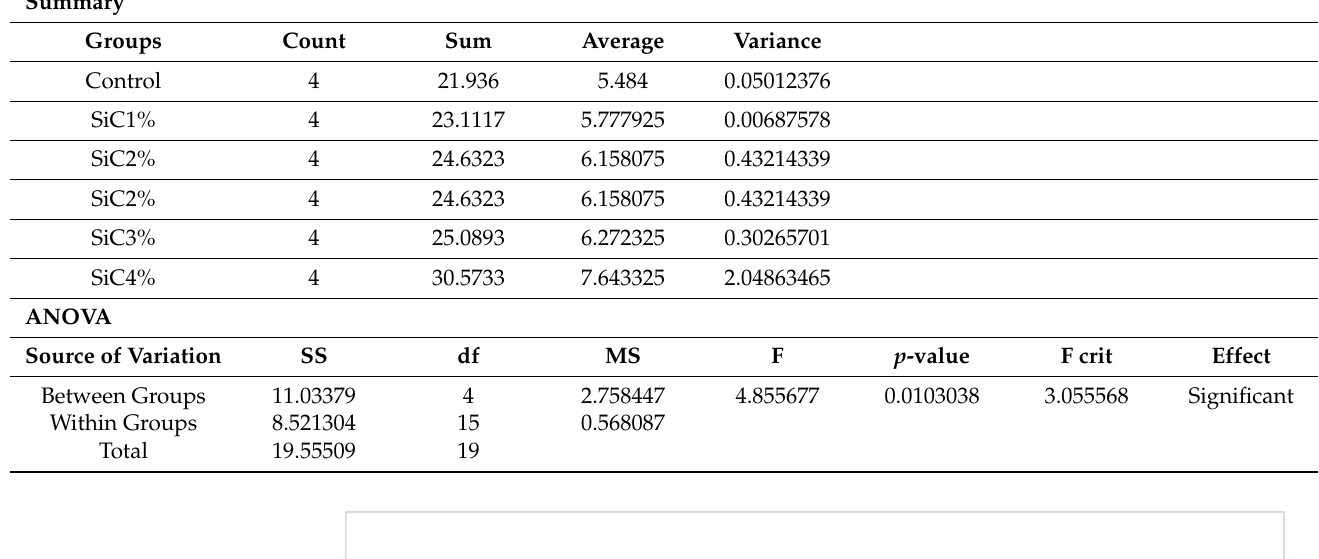
Table 4. ANOVA for Flexural Strength Variation with increased WC percentage.